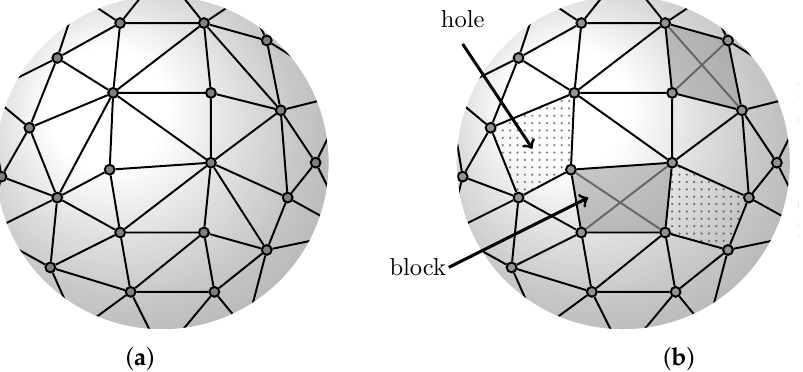
Figure 61. A triangulated sphere ( a ). Removing some edges creates holes (dotted), and replacing the edges elsewhere creates blocks (shaded) ( b ). Figure by Elissa Ross, reused with permission.